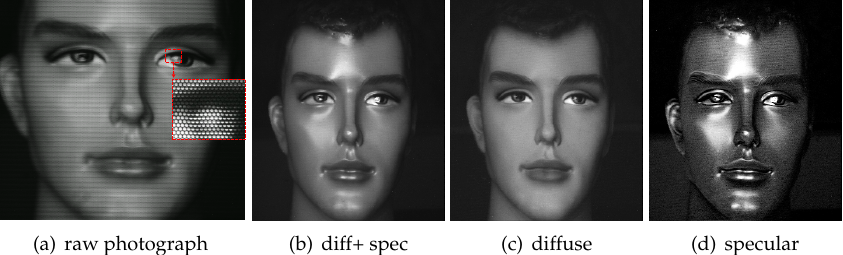
Figure 3. ( a ) A raw photograph of a mannequin taken with our TPLF camera. ( b ) Parallel polarized (diffuse + specular) component and separated ( c ) diffuse and ( d ) specular component images generated from the raw image. The mannequin is made of glossy plastic (( c ) Eurographics Association 2016 [9]).